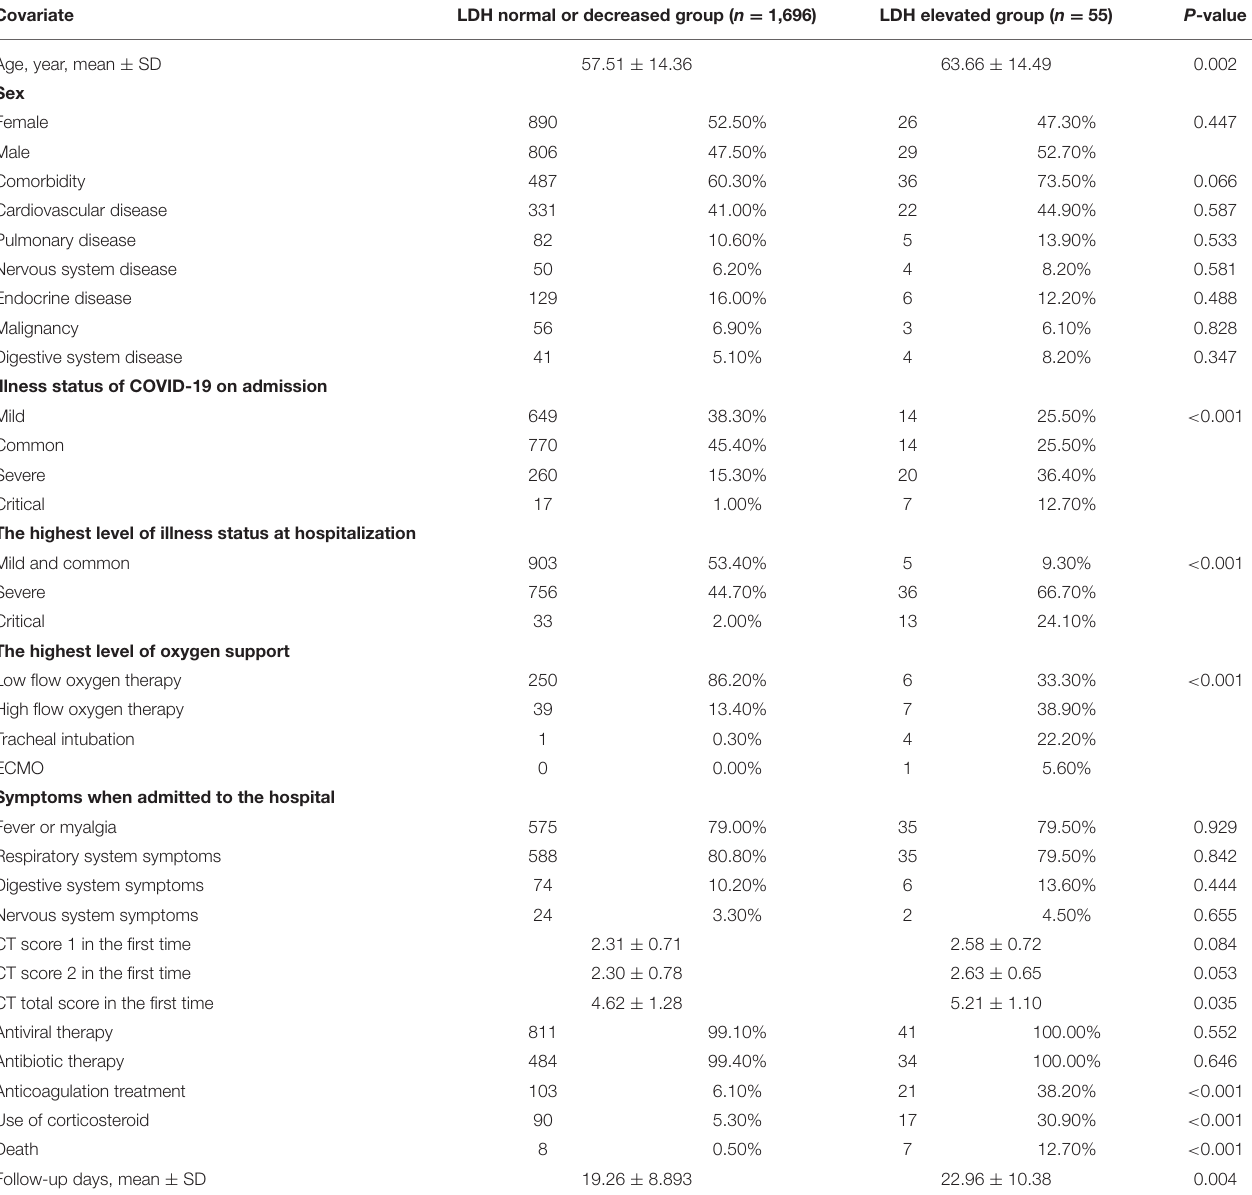
TABLE 1 | Demographic and clinical information for COVID-19 patients in different LDH level. Covariate LDH normal or decreased group ( n =